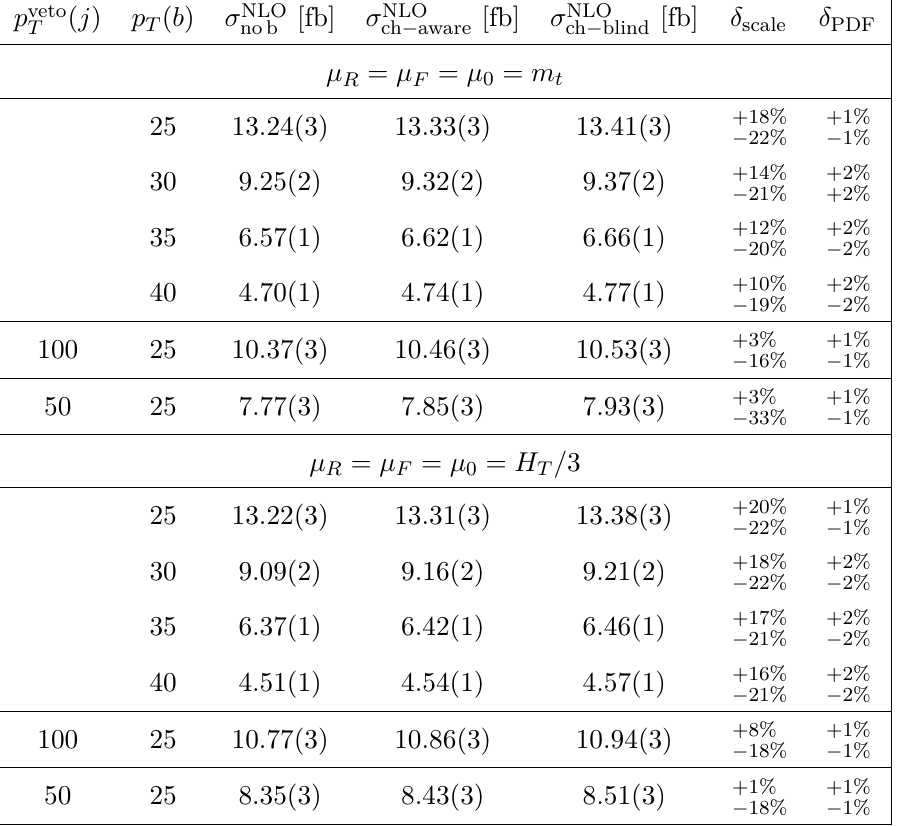
Table 6 . NLO integrated fiducial cross section for the pp → e + ν e µ − ¯ ν µ b ¯ b b ¯ b + X production process √ at the LHC with s = 13 TeV for µ 0 = m t and µ 0 = H T / 3 . Theoretical results with and without the initial state b contributions are provided for the NLO NNPDF3.1 PDF set. Results for four different values of the p T ( b ) cut and for a jet veto with p veto ( j ) = 50 , 100 GeV are additionally T provided. Also given are the theoretical uncertainties due to scale variation ( δ scale ) and PDFs ( δ PDF ) . Finally, Monte Carlo integration errors are shown (in